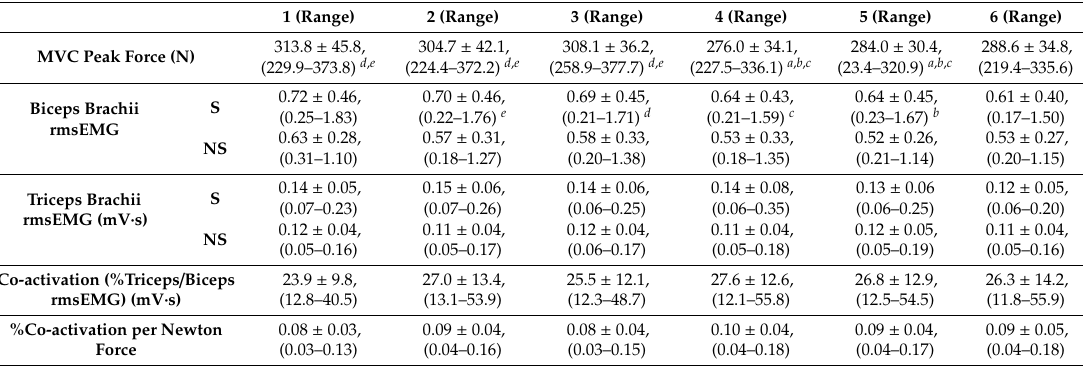
Table 2. Mean ± SD of MVC force and electromyographic data, collapsed across sessions (no-stimulation, stimulation) and conditions (external condition, internal condition), for MVC trial 1 to trial